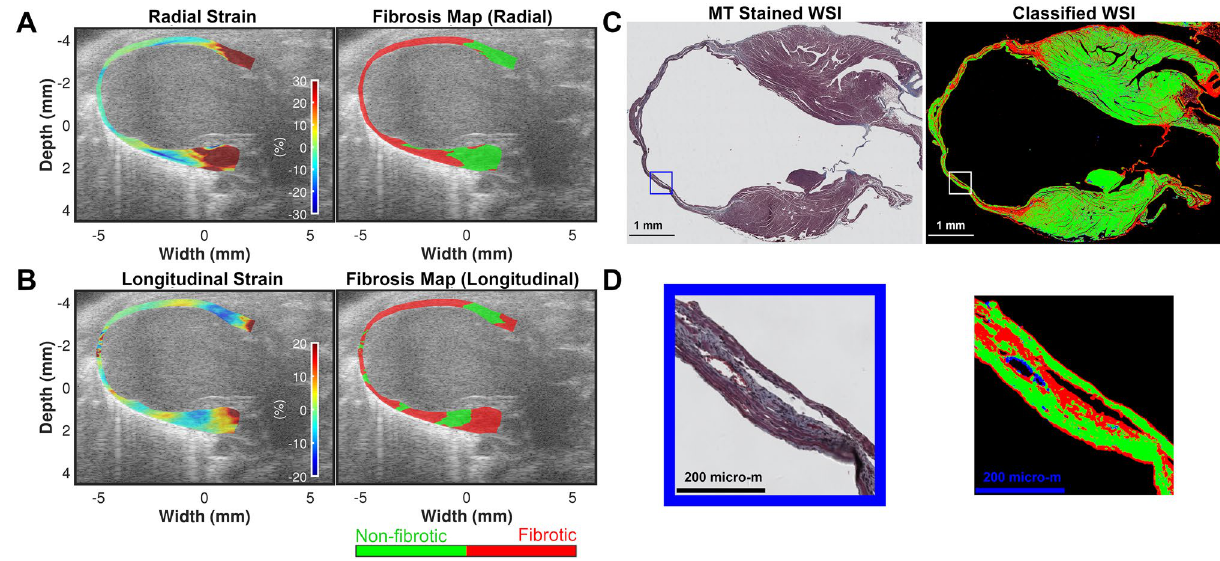
Figure 4. Qualitative comparison between cardiac fibrosis maps estimated using strain images in vivo and WSI data ex vivo in a female BALB/CJ mouse after myocardial infarction surgery. ( A ) Left panel: Cumulative ES radial strain image at Day 14. Right panel: Corresponding cardiac fibrosis map. ( B ) Cumulative ES longitudinal strain image at Day 14. Right panel: Corresponding cardiac fibrosis map. Red = fibrotic region, green = non- fibrotic region. ( C ) Left panel: MT stained WSI. Right panel: Corresponding classified image generated using a random forest classifier. Red = fibrotic region, green = non-fibrotic region, blue = blood clot, black = background. ( D ) Left panel: A magnified region-of-interest extracted from the WSI image demonstrating collagen deposition in the fibrotic regions. Right panel: Corresponding classified image using the random forest